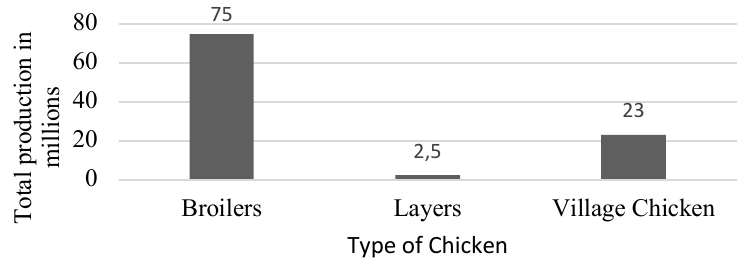
Fig. 1. . Zambia total chicken production in